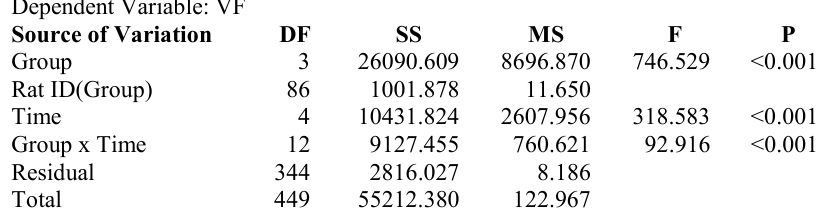
Figure A3. Ipsilateral Two-Way RM ANOVA statistical analysis for behavioral portion (presented in Figure 1).